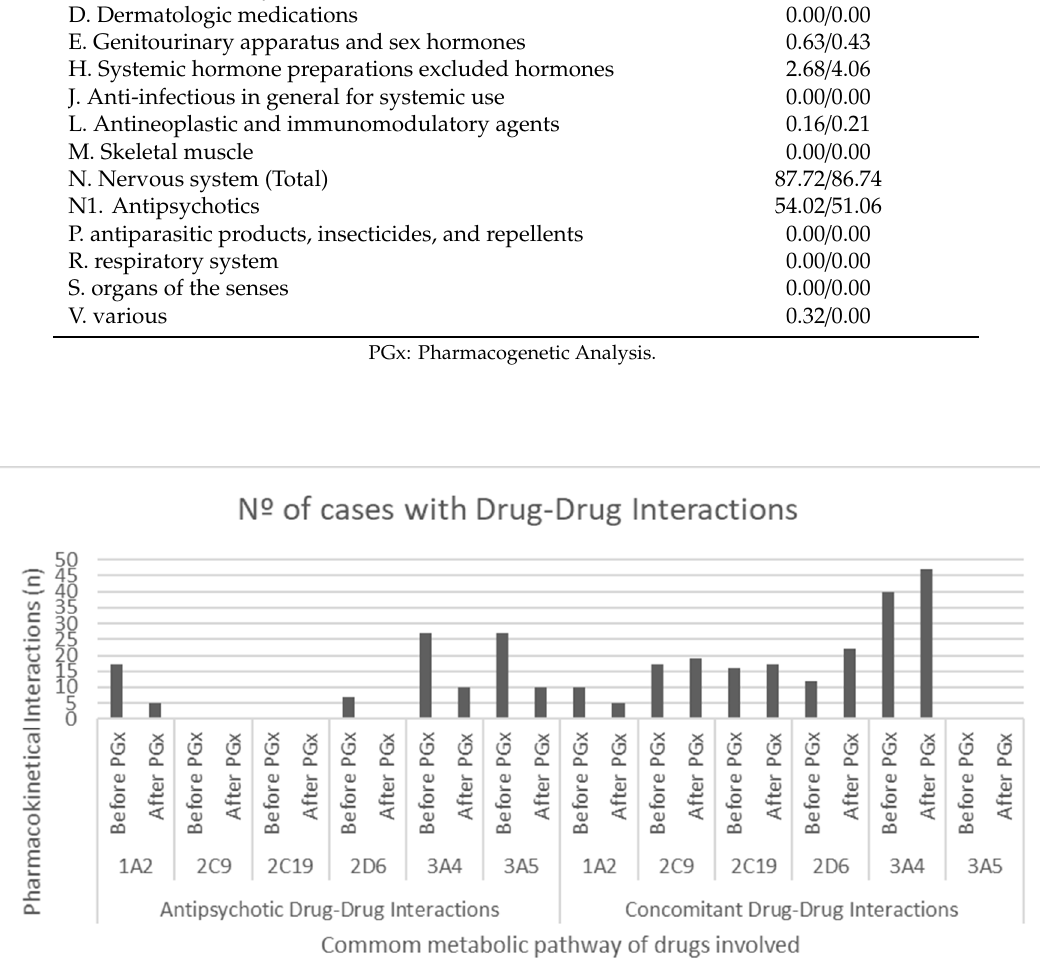
Table 4. Infratherapeutic dosage percentage.